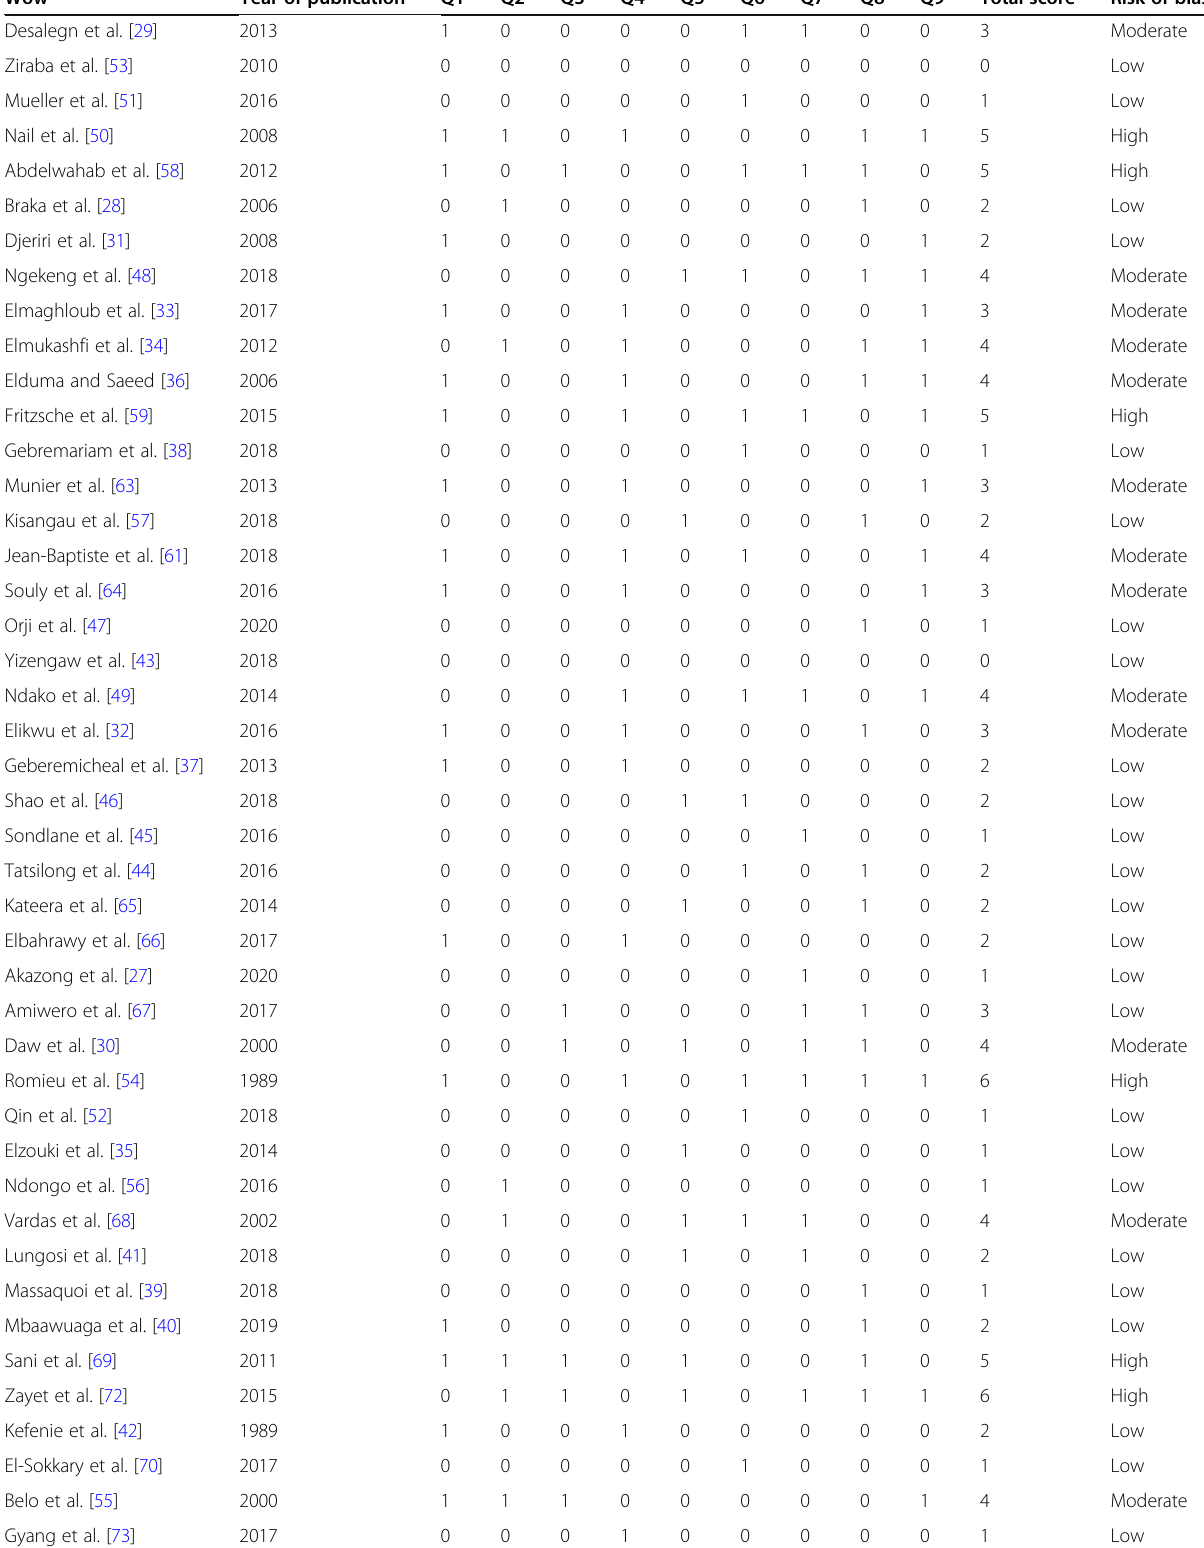
Table 2 Risk bias assessment of individual studies included for meta-analysis on prevalence of hepatitis B and C in